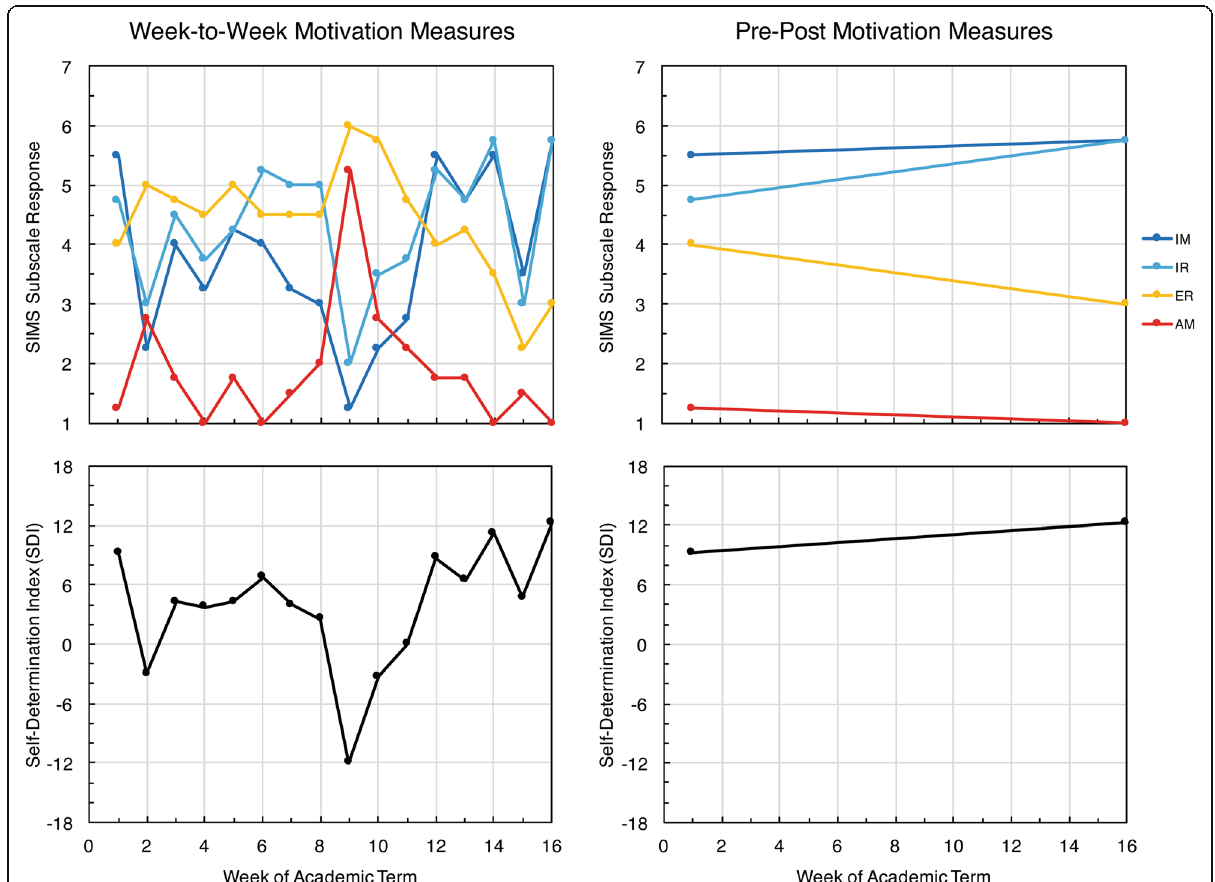
Fig. 4 An individual student ’ s SIMS motivation subscale data (top) and calculated SDI values (bottom) over one semester in a college course, demonstrating insights to be gained by implementing longitudinal sampling (left) over pre-post sampling (right), and illustrating the situational- level variation in a learner ’ s motivation responses. Note the increase in amotivation and decrease in identified regulation and intrinsic motivation between weeks 8 and